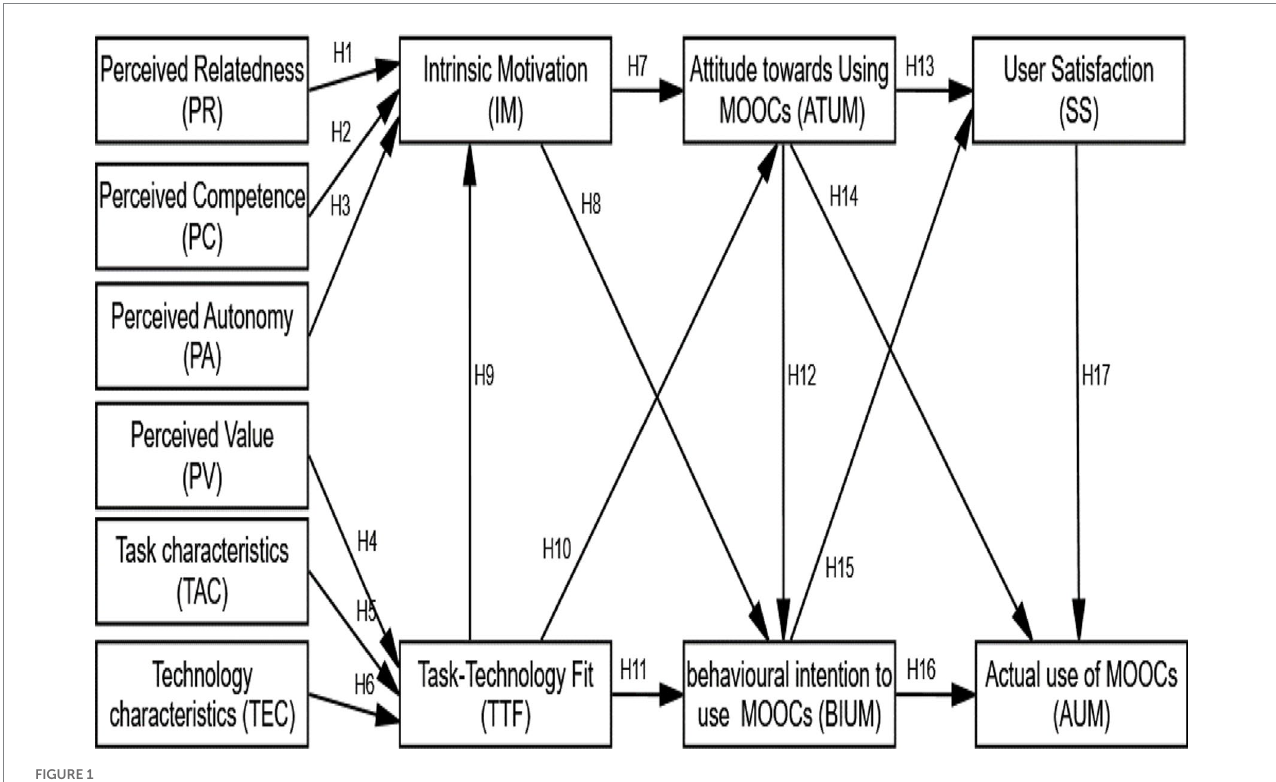
FIGURE 1 Research